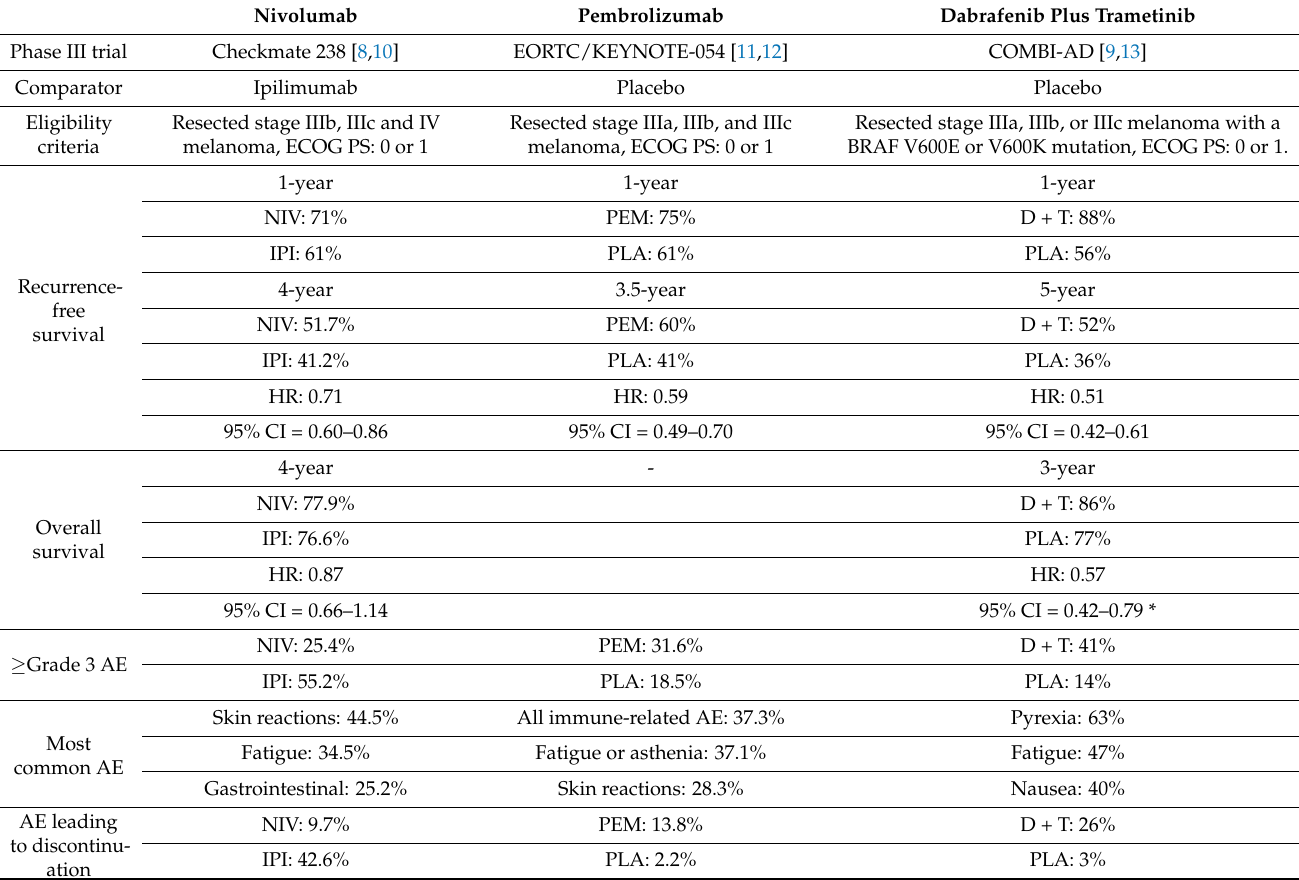
Table 1. Phase III trial results for adjuvant treatments of